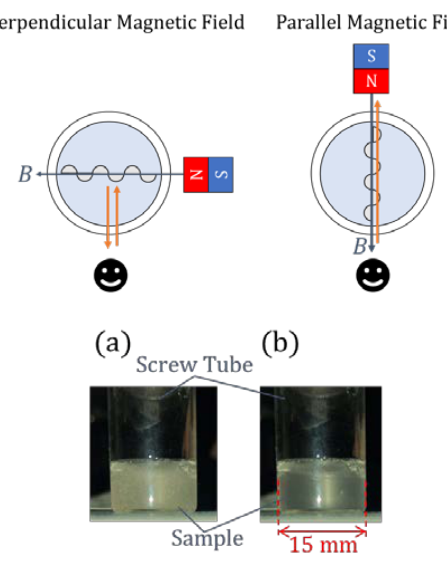
Figure 12. Photographs of reflections of the suspension in a dark room with a magnetic field B applied ( a ) perpendicular and ( b ) parallel to the light propagation direction. When the light direction is parallel to the magnetic field in ( b ), the light is more transmitted. The sample tube containing the suspension was irradiated from the front by the light emitting diode of a smartphone. The photographic images are captured from the movie (See also Video S3) taken with the smartphone held by the observer in the front, who rotated the magnetic field by moving the magnet from the side to the back of the tube.